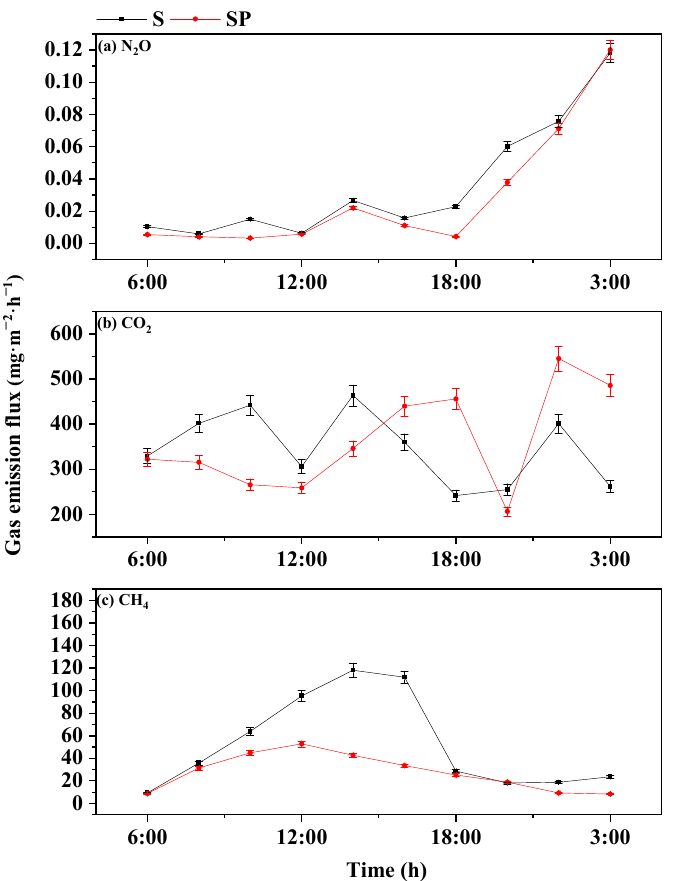
Figure 7. Diurnal variation of GHG emission fluxes from the agricultural drains. ( a ) N 2 O emission flux; ( b ) CO 2 emission flux; ( c ) CH 4 emission flux.